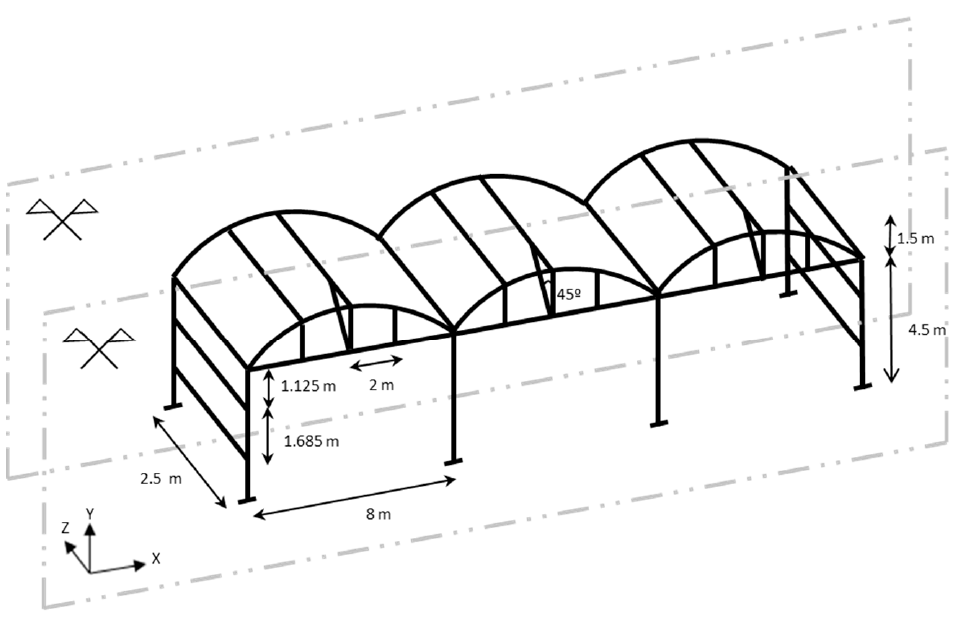
Figure 6. Symmetry planes and dimensions of the studied greenhouse model.